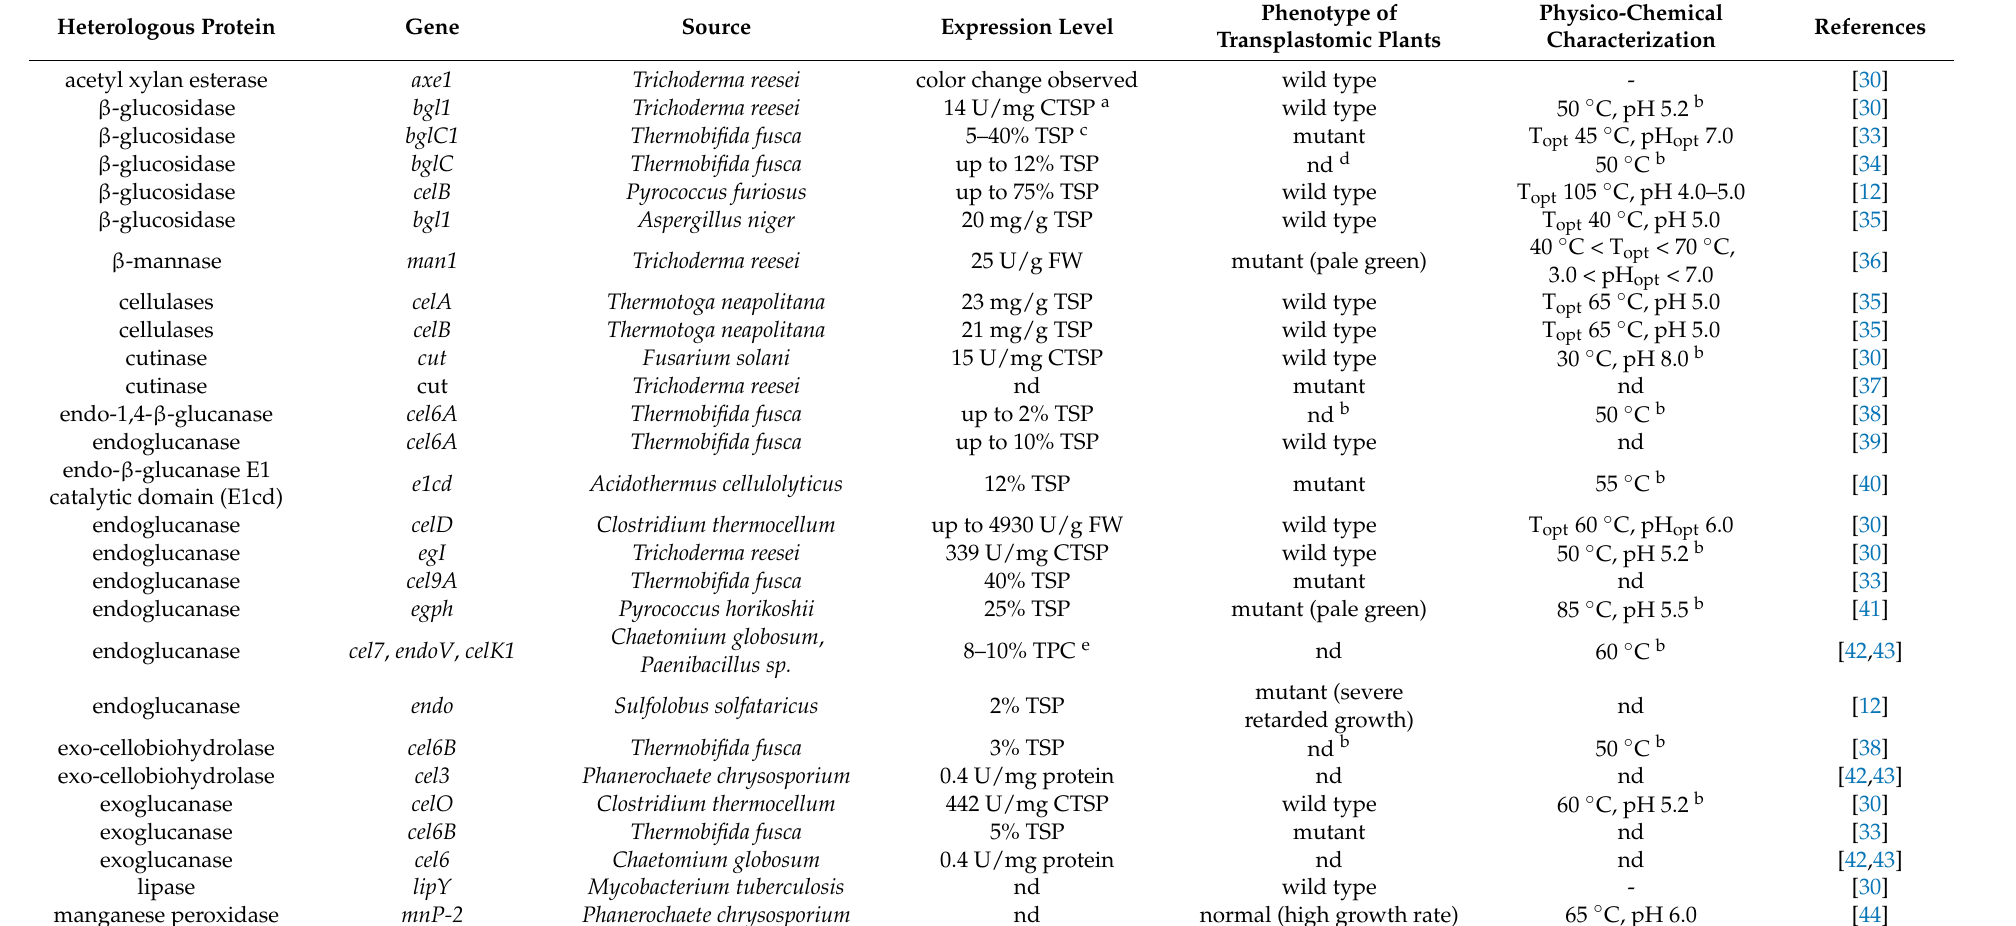
Table 2. Expression of lignocellulolytic enzymes in chloroplasts of higher